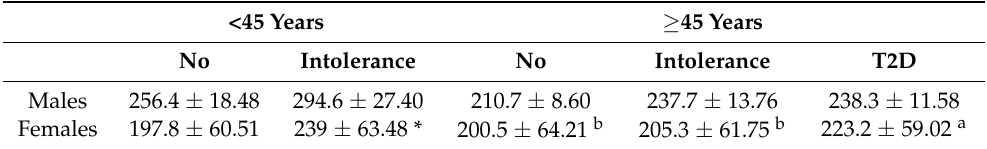
Table A1. Proline concentration according to glucose